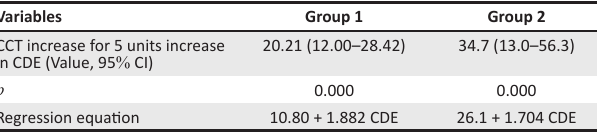
TABLE 10: Linear regression prediction of central corneal thickness increase according to cumulative dissipated energy used during phaco.